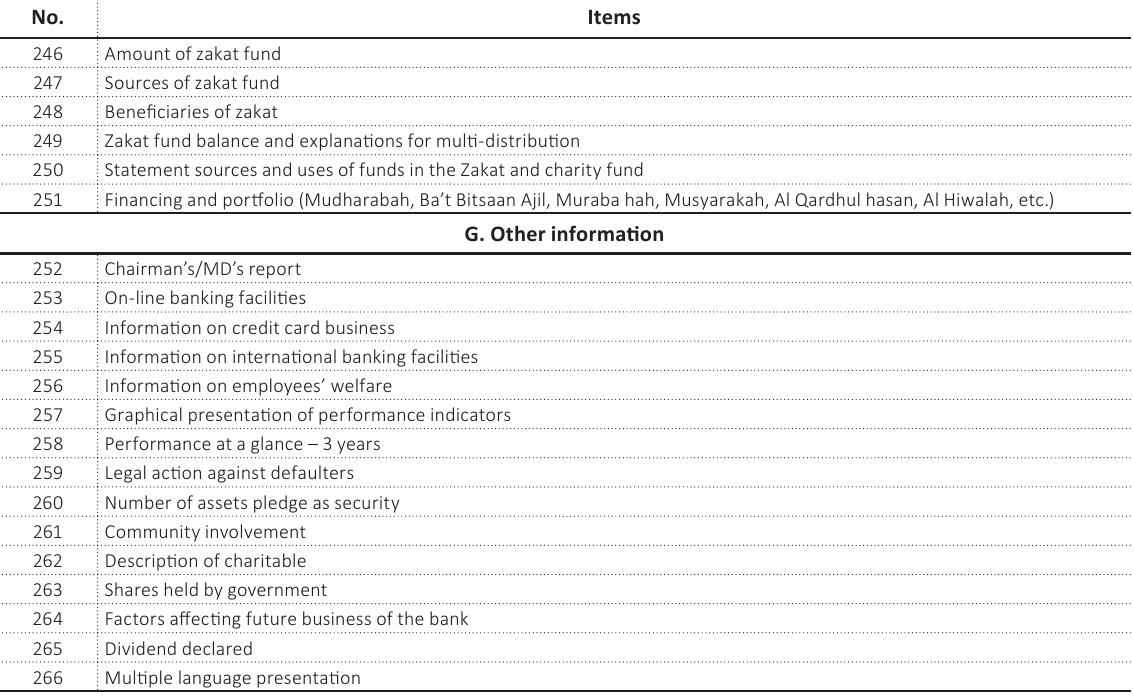
Table A1. (cont.) Voluntary disclosure index